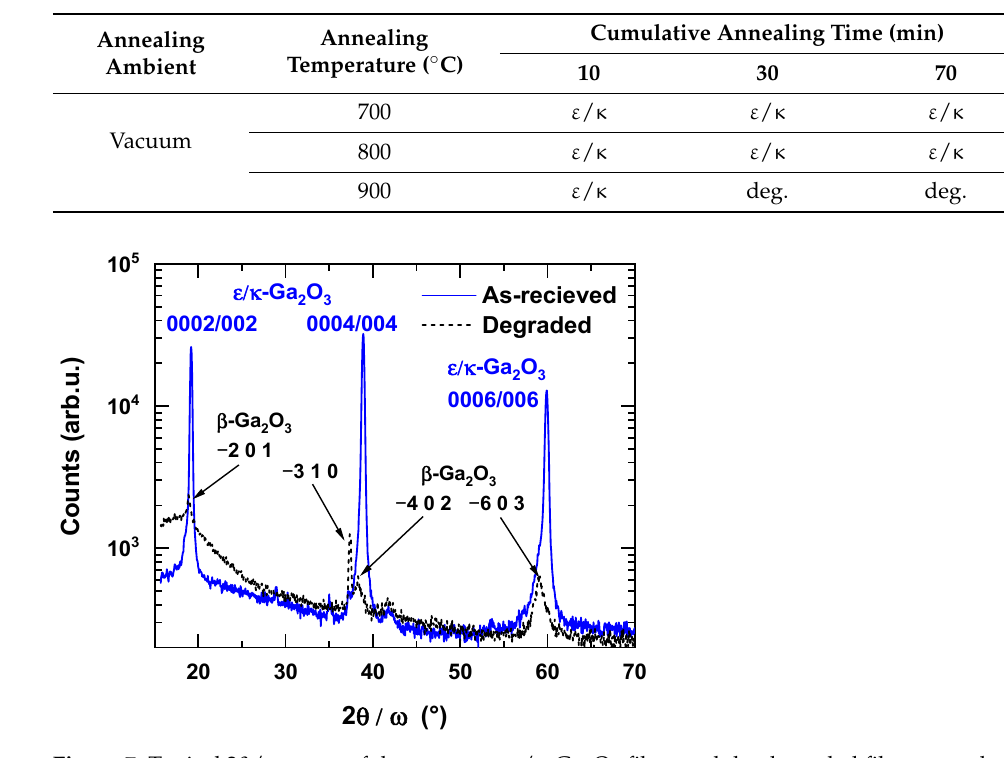
Figure 7. Typical 2 θ / ω scans of the as-grown ε / κ -Ga 2 O 3 films and the degraded films annealed at 900 ◦ C for 30 900 °C for 30 min.